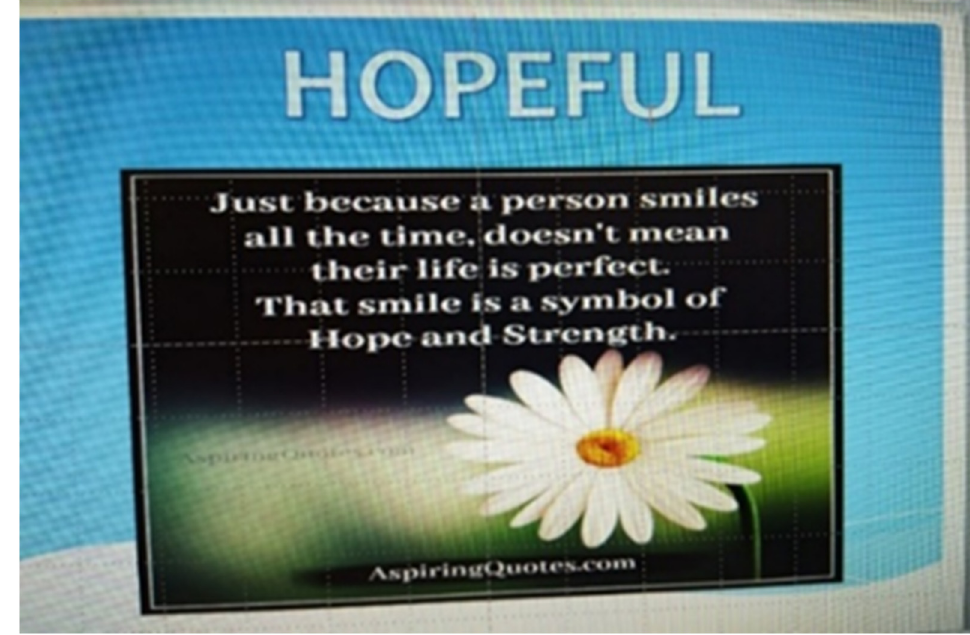
Figure 5. Photograph by Participant F.